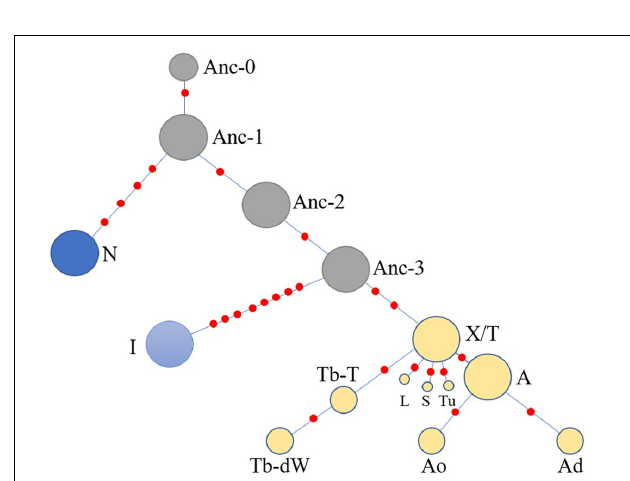
FIGURE 5 | Simplified network illustrating relationships among main haplotypes. The haplotypes are correspondent to those in Figure 4 .